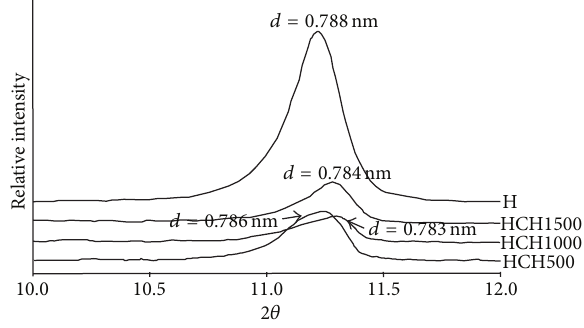
Figure 2: 𝑑 -spacing of the primary XRD peaks (003) of original hydrocalumite and those regenerated from the samples calcined at 500, 1000, and 1500 ∘